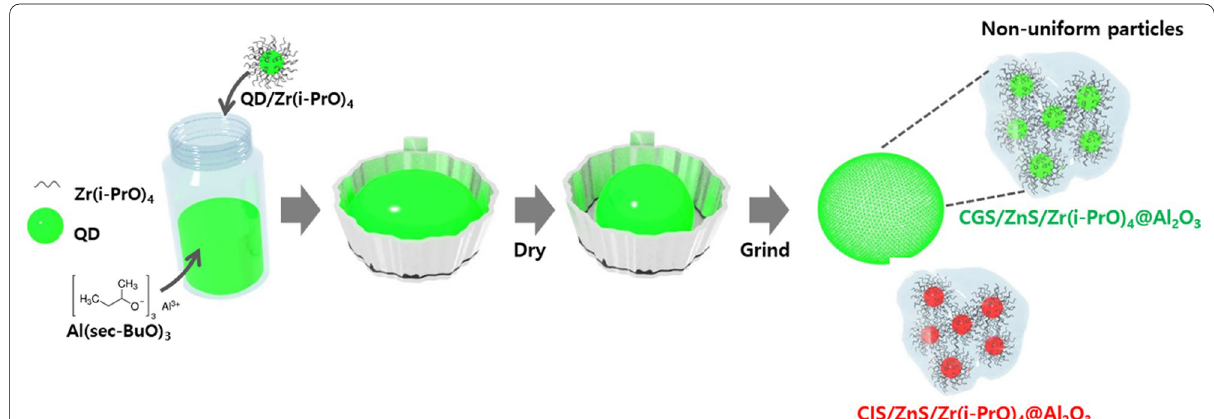
Fig. 6 Schematic diagram of ex-situ hydrolysis reaction of Al(sec-BuO) 3 precursor using purified pristine and Zr(i-PrO) 4 -complexed QD solutions under ambient moisture at room temperature